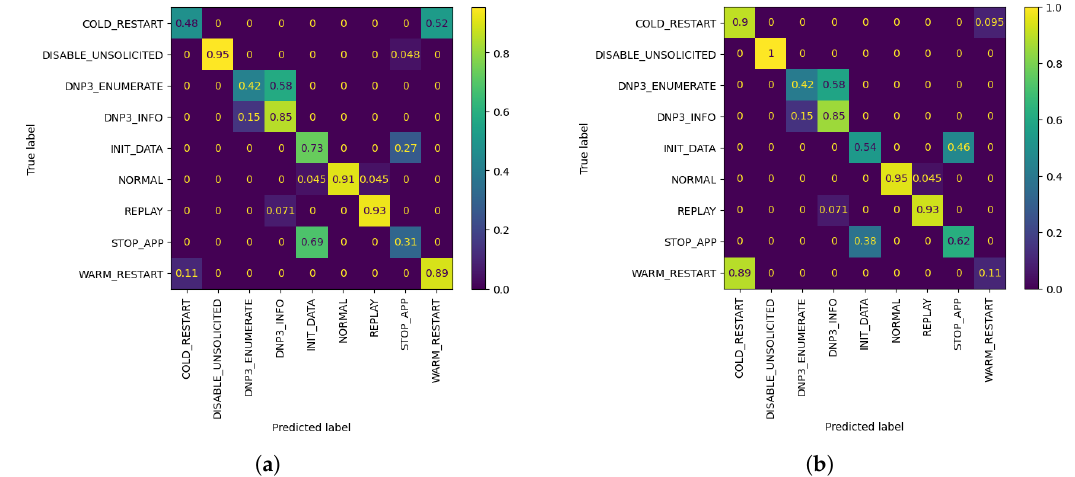
Figure 9. W1 Confusion Matrices. ( a ) W1’s evaluation of global FL model after r = 3 using its evaluation dataset; ( b ) W1’s evaluation of customized model by AL, after Q = 20 queries, using its evaluation dataset.